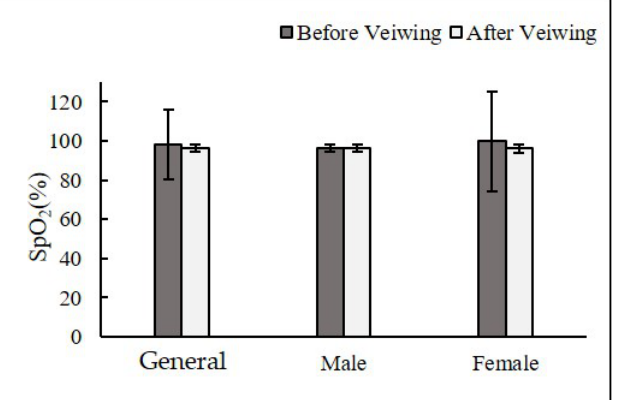
Figure 3. Changes in blood pressure before and after viewing the landscape forest pictures (n = 120; mean ± SD; * p < 0.05; ** p < 0.01; *** p < 0.001; verified by a paired t-test): ( a ) systolic blood pressure changes; ( b ) diastolic blood pressure changes.